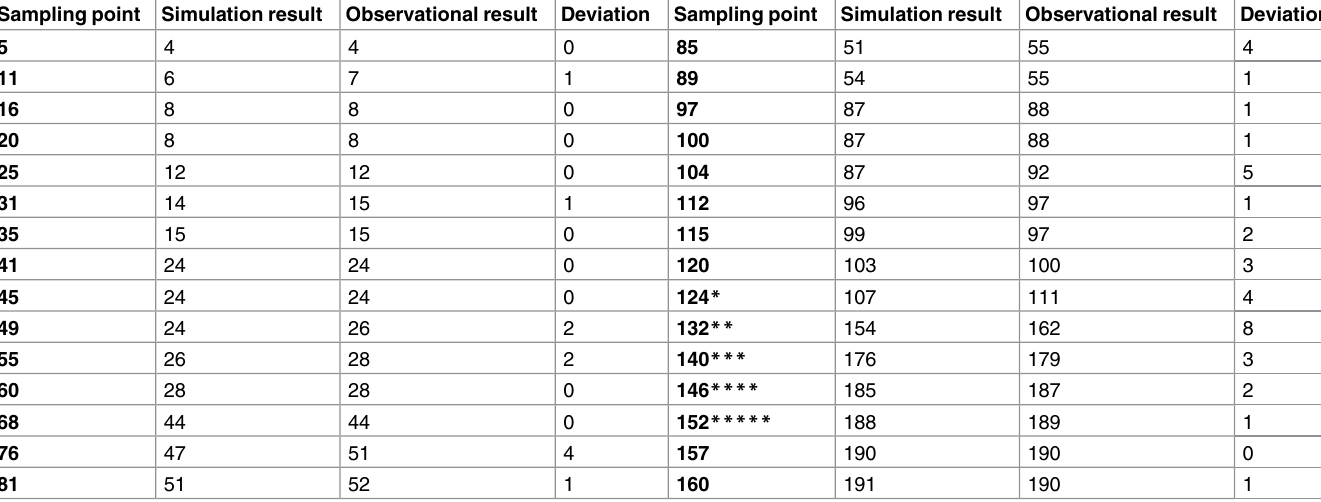
Table 5. Number of cells in embryo over time sampled every5 minutes from simulation and observational data.